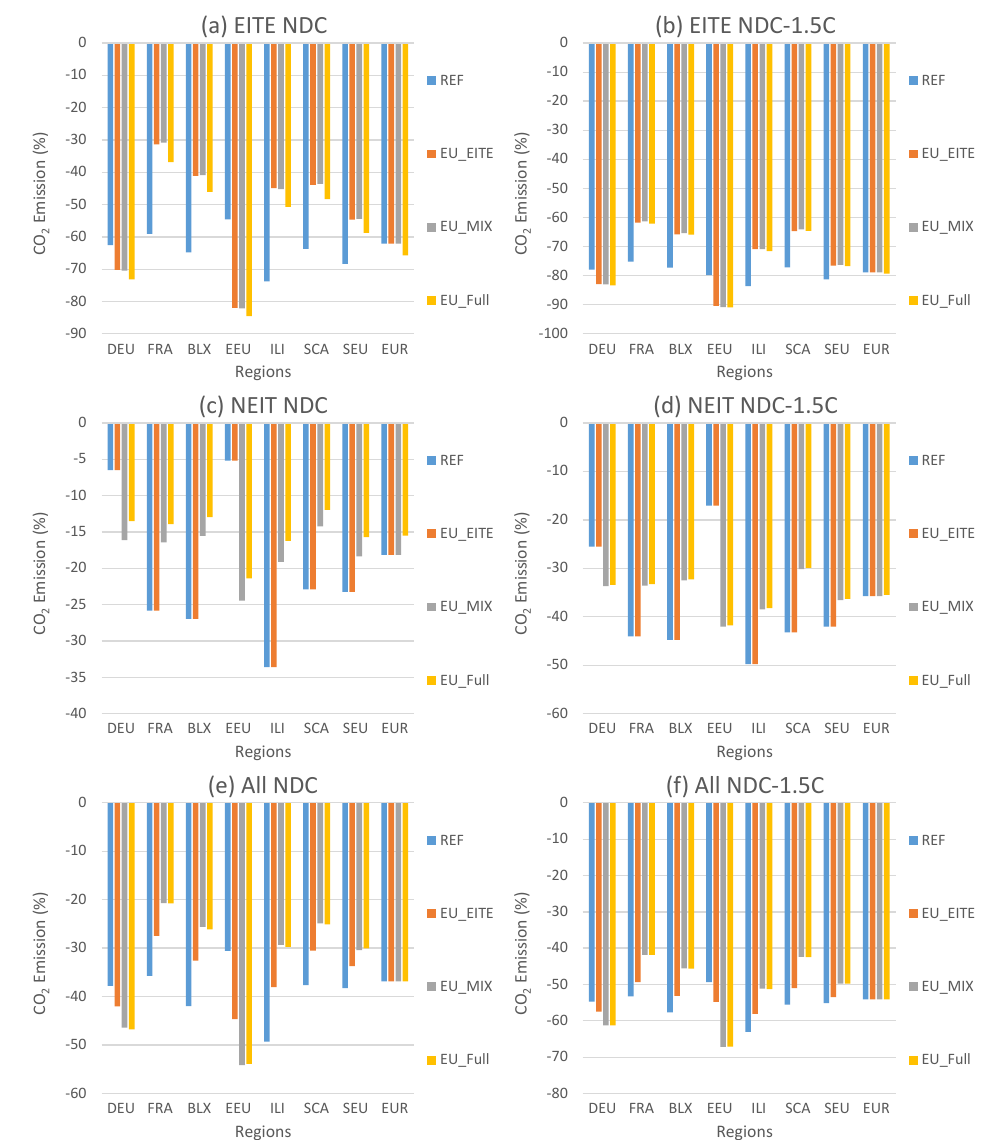
Figure 6. Percentage change in CO 2 emission in EITE, NEIT, and ALL sectors for different policy scenarios and NDCs using the IEO